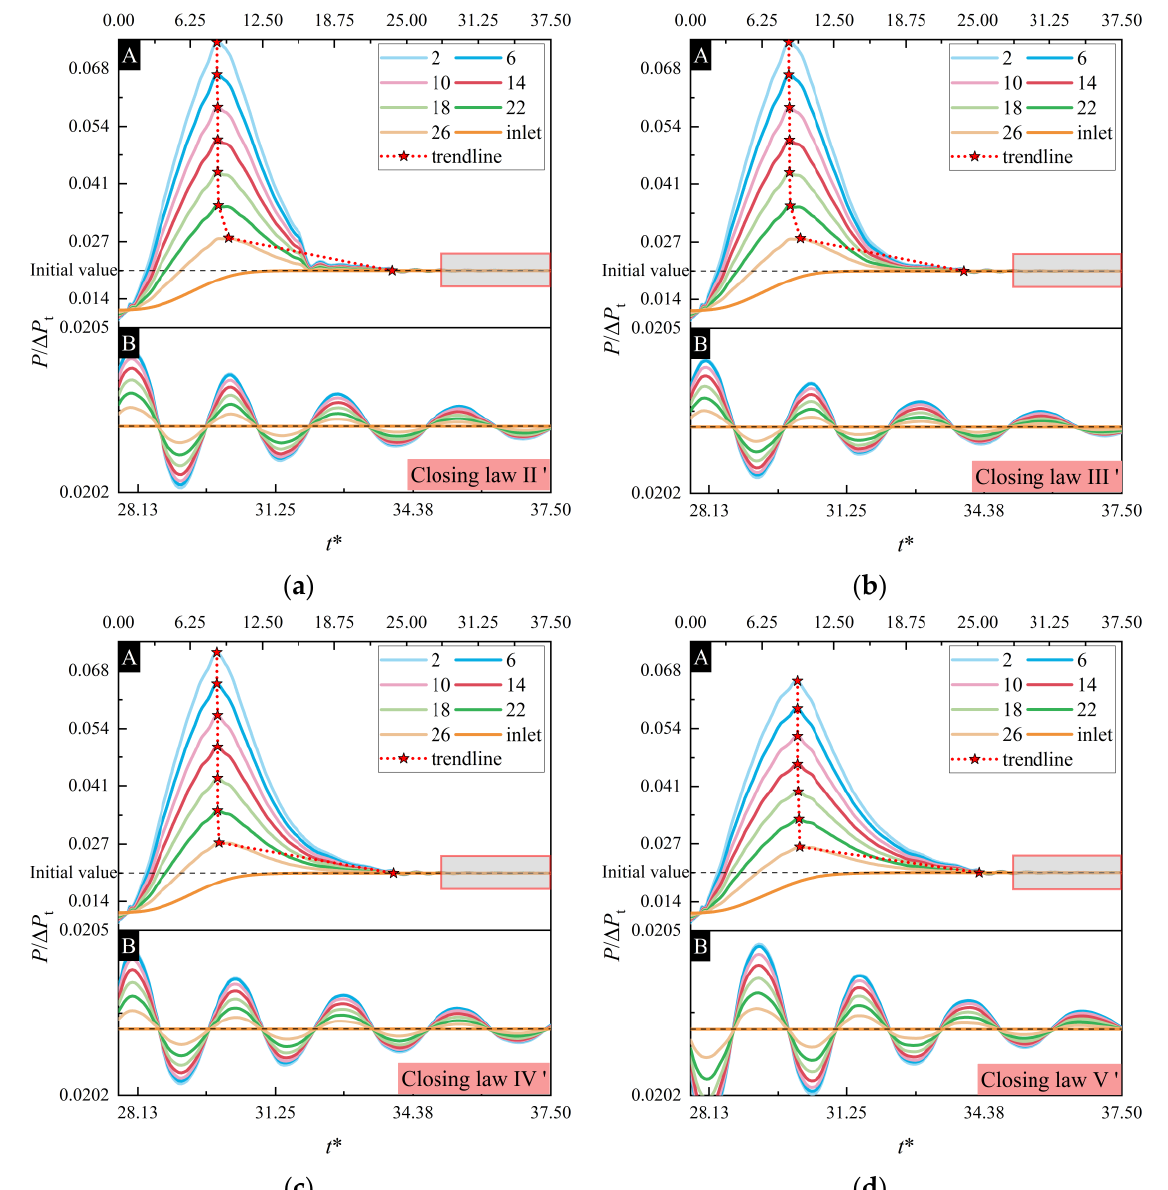
Figure 10. The influence of valve closing laws based on closing time t * = 31.25 on water hammer pressure: ( a ) closing law II ′ . ( b ) closing law III ′ . ( c ) closing law IV ′ . ( d ) closing law V ′ .